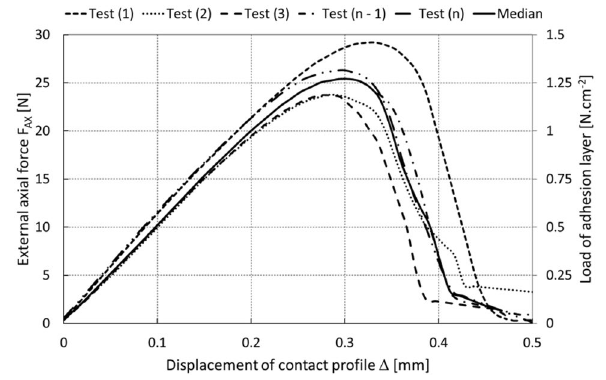
Fig. 16 Microscopic contact profile of an elastomer with a relatively smooth glass